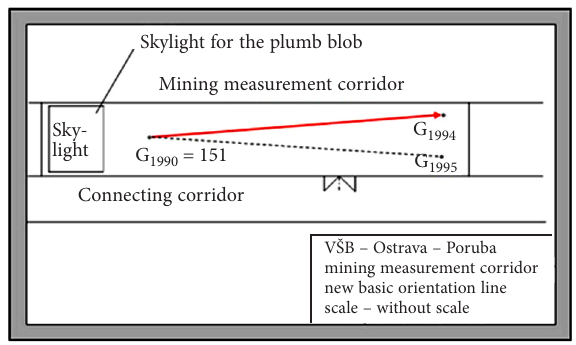
Figure 3. Mining measurement base at VŠB-TUO